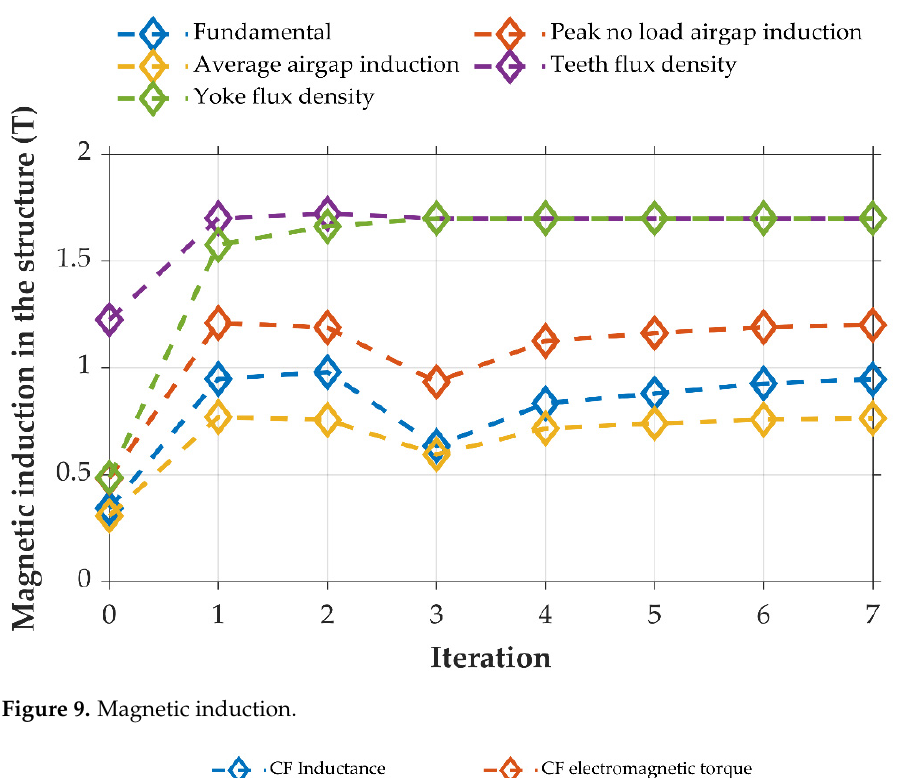
Figure 9. Magnetic induction.